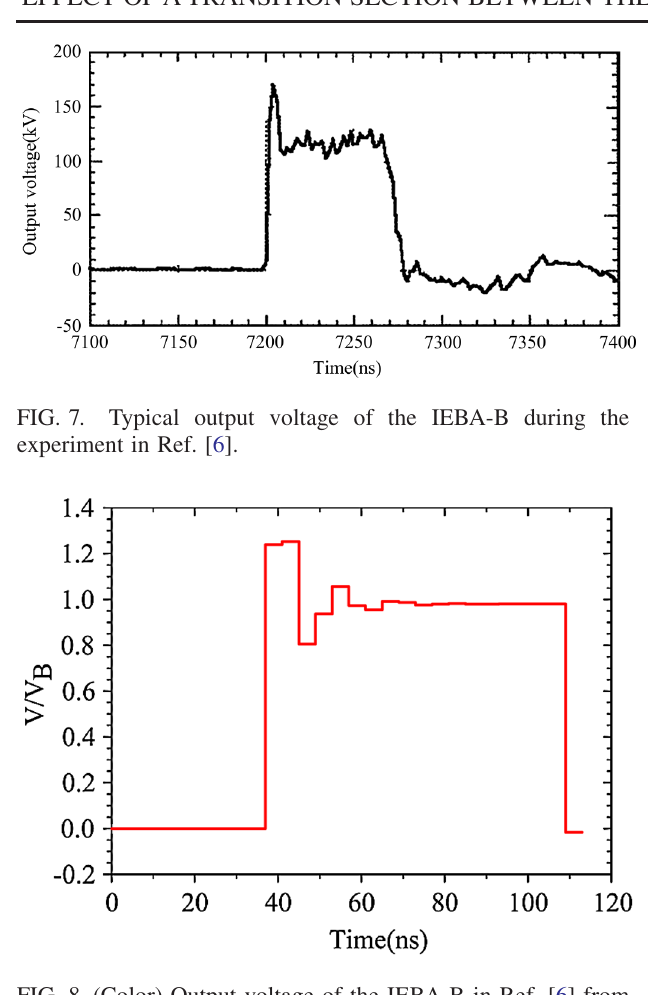
FIG. 8. (Color) Output voltage of the IEBA-B in Ref. [6] from the theoretical